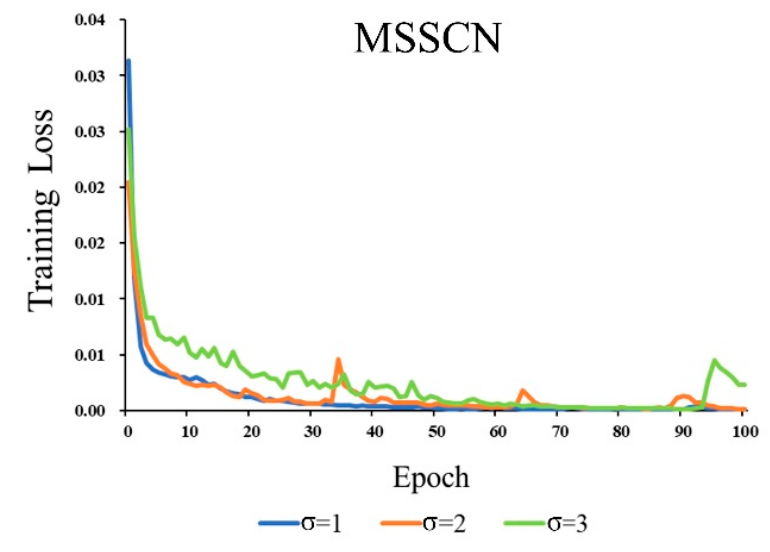
Figure 5. Training loss of the MSSCN at different Gaussian kernel parameters.